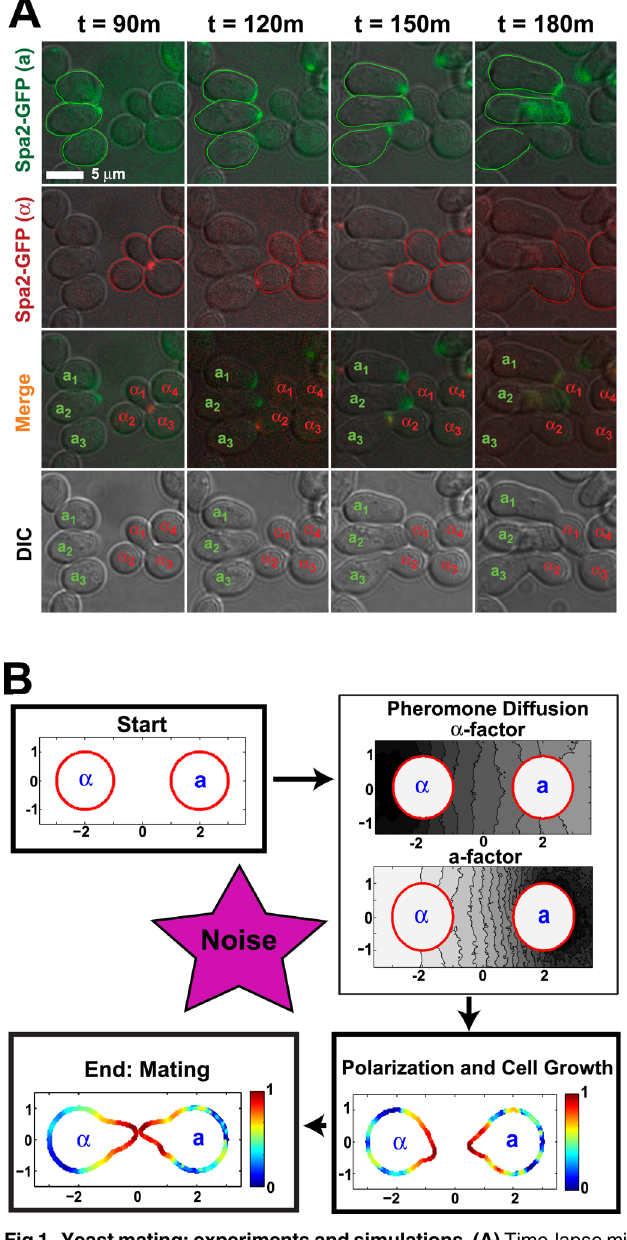
Fig 1. Yeast mating: experiments and simulations. (A) Time-lapse microscopy of mating yeast cells. Wild- type bar1 Δ a -cells (left) and α -cells (right) were imaged over a two-hour period starting at t = 90m. The polarisome was labeled with Spa2-GFP ( a , first row, cells outlined in green) and Spa2-mCherry ( α , second row, cells outlined in red). The GFP and mCherry channels are merged (third row) with the three a -cells and four α -cells labeled. The DIC images are shown in the fourth row. The pairs a 1 - α 1 and a 3 - α 2 mated successfully. The presence of Bar1 over time will degrade the α -factor in a mating mix, and so to maximize the mating response we employed a bar1 Δ strain. Scale bar = 5 μ m. (B) Schematic diagram of yeast mating simulations. At the start, two cells are separated by 4 microns. The two mating pheromones ( a -factor and α - factor) diffuse from their respective sources ( a -cell and α -cell) which are sensed by the respective partners. The spatial dynamics of the biochemical reaction network are triggered resulting in the polarization of the membrane species. The boundary of the cell moves in response to the concentration of the polarized species resulting in the growth of a mating projection. Mating ends when the tips of the projections contact one